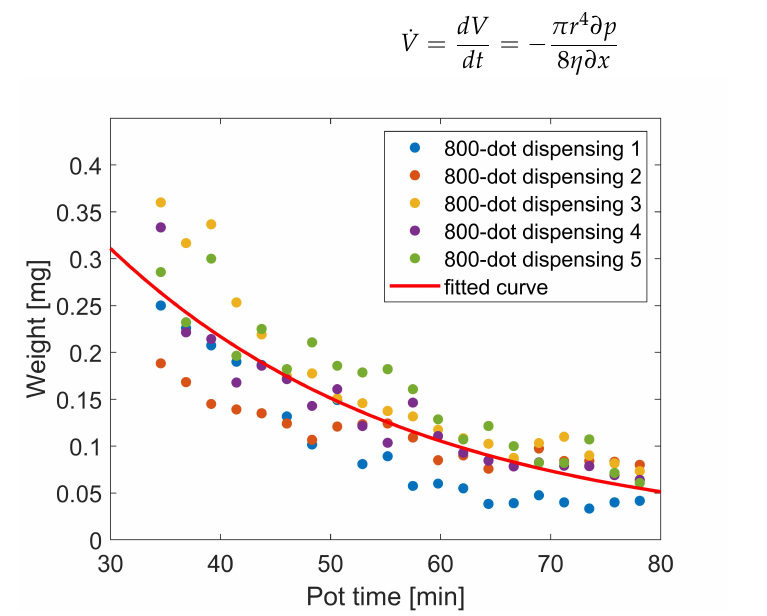
Figure 5. Average mass of an adhesive dot over pot time. Five series of 20 foil substrates with 40 dots each are consecutively dispensed during 50 min after adhesive preparation (dispensing pressure 5bar, stand-off distance 150µm, dispensing time